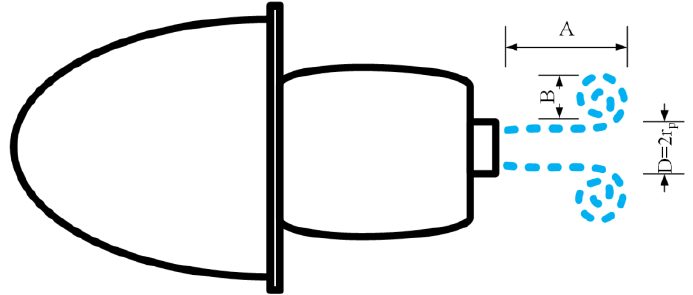
Figure 14. Schematic diagram of vortex ring.